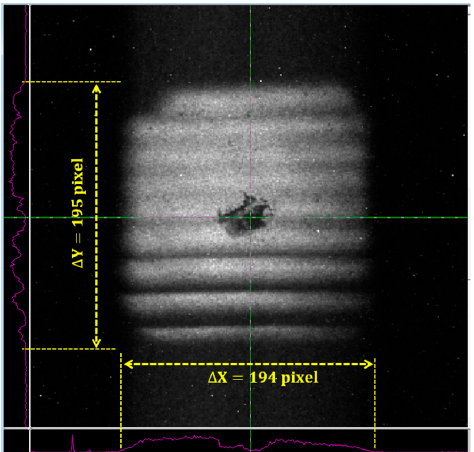
Figure 7. The position and size of the rear waist after adjustment. (The yellow arrow in the figure indicates the number of pixels corresponding to each length.)